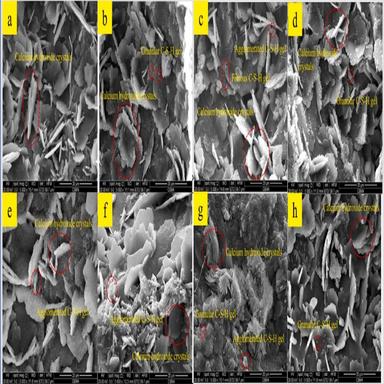
Microscopic images of CH in the specimen (magnified 5000 times): (a) Specimen without subsequent hydration; (b) Specimen in laboratory environment at 394d; (c) Subsequent hydration at 132d CS; (d) Subsequent hydration at 132d NS; (e) Subsequent hydration at 265d CS; (f) Subsequent hydration at 265d NS; (g) Subsequent hydration at 394d CS; (h) Subsequent hydration at 394d NS.